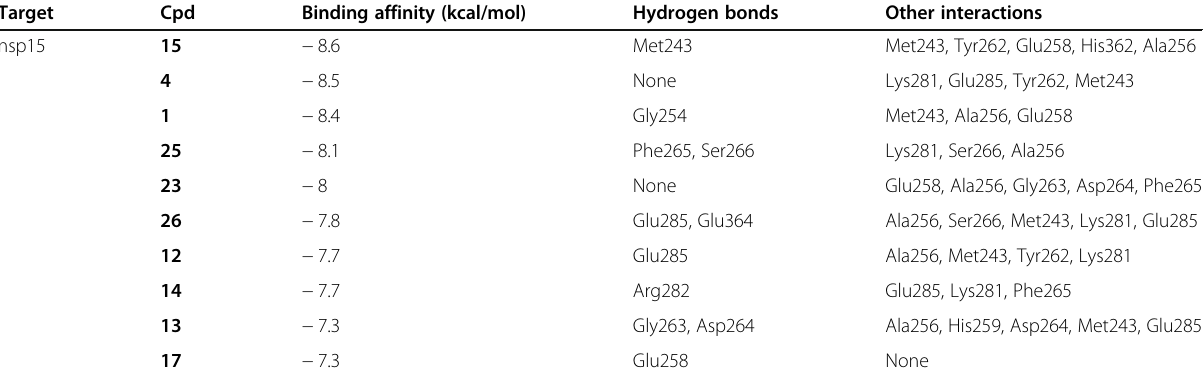
Table 4 Binding affinities and interactions of top ten ligands against nsp15 Target